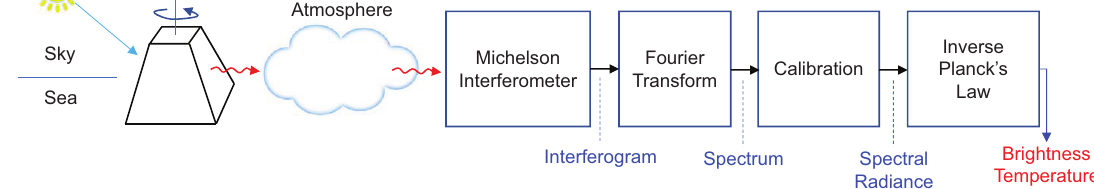
Figure 1. Overall process of the brightness temperature extraction using the passive open path Fourier transform infrared (FTIR) imaging system.